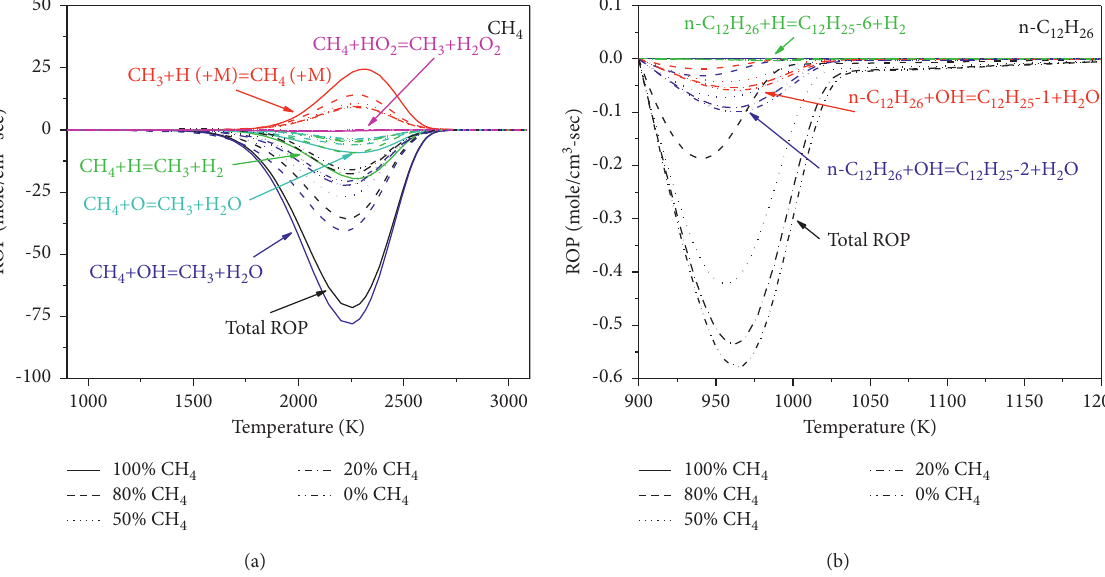
4 and n-C 12 H 26 radical through the key reactions with various methane-n-